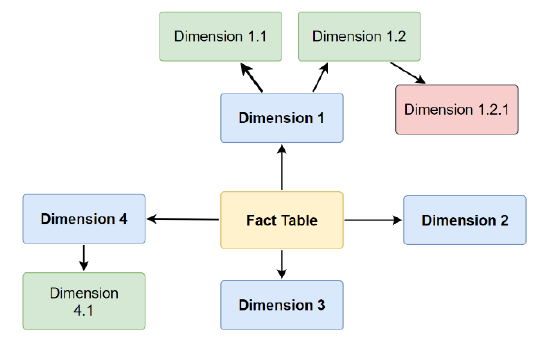
Figure 7. A Snowflake schema